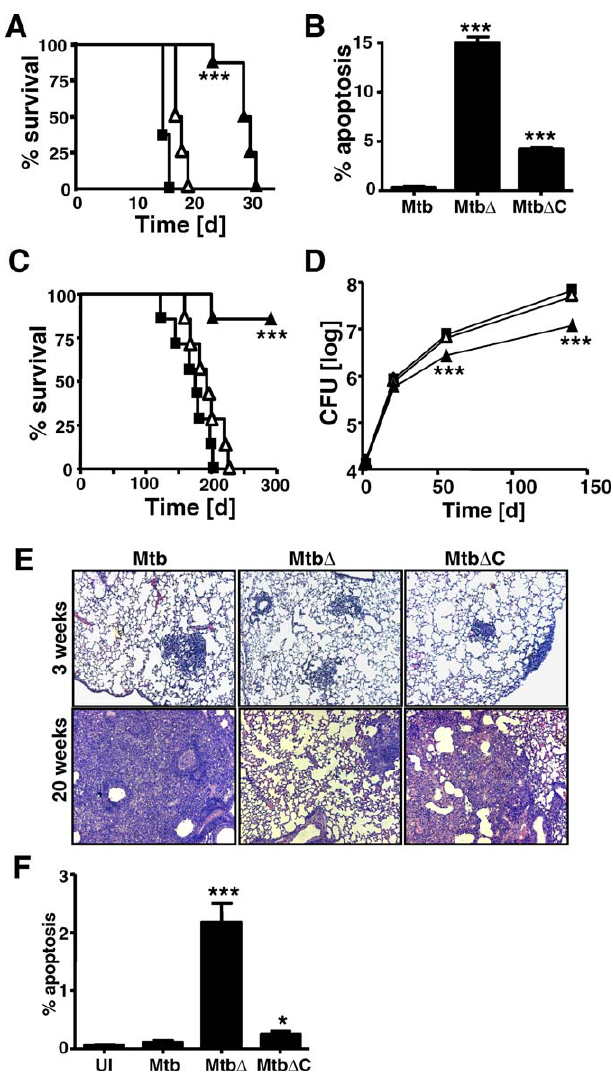
Figure 4. Identification of nuoG as a Mycobacterial Virulence Determi- nant (A) Survival of SCID mice after intravenous infection with 10 6 wild-type Mtb (squares), D nuoG mutant (filled triangles), or complemented mutant bacilli (open triangles). n ¼ 7 mice per group. (B) Apoptotic cells in lung tissues of SCID mice after 14 d of infection were quantified using TUNEL peroxidase staining by microscopy as explained in Figure